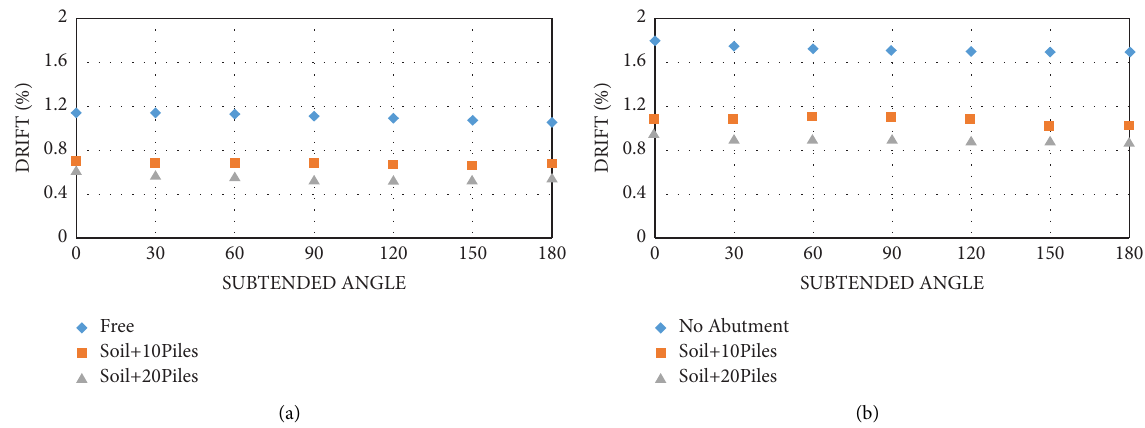
Figure 20: Real drift demands of side columns in all bridge confgurations using GMs compatible to (a) DBE and (b) MCE response